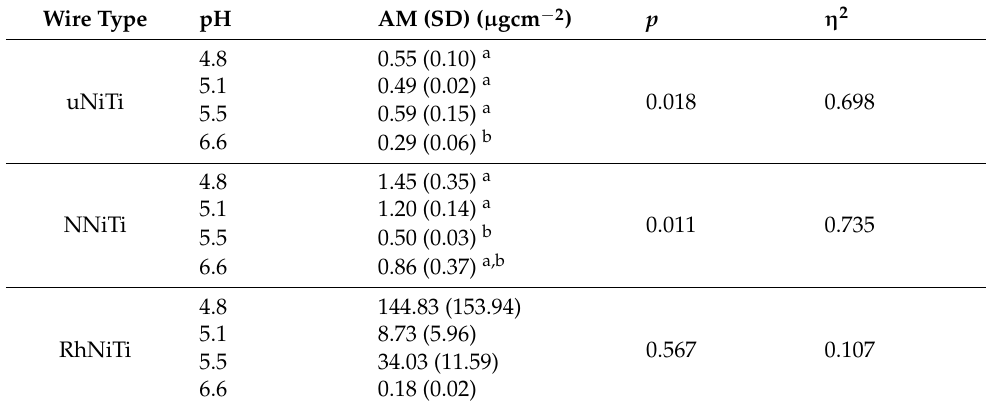
Table 1. Distribution of the cumulative Ni-ion release in relation to the pH of artificial saliva and the wire type.